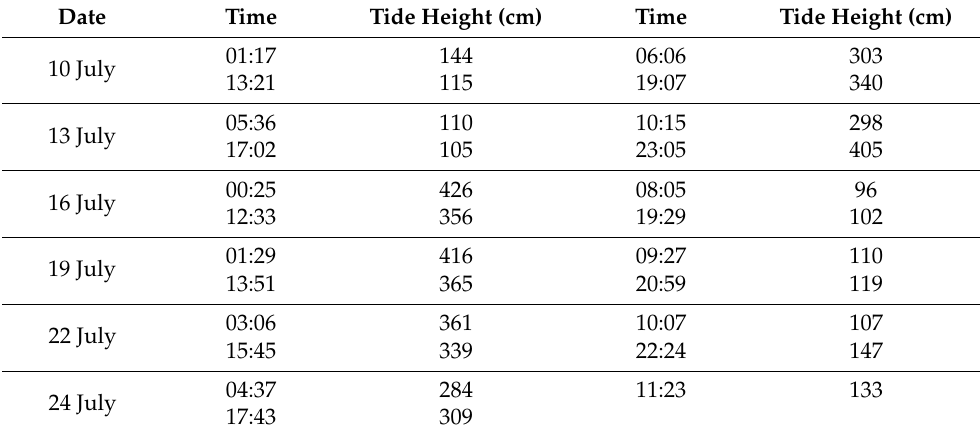
Table 2. The highest and lowest tide height during the 15-day tidal